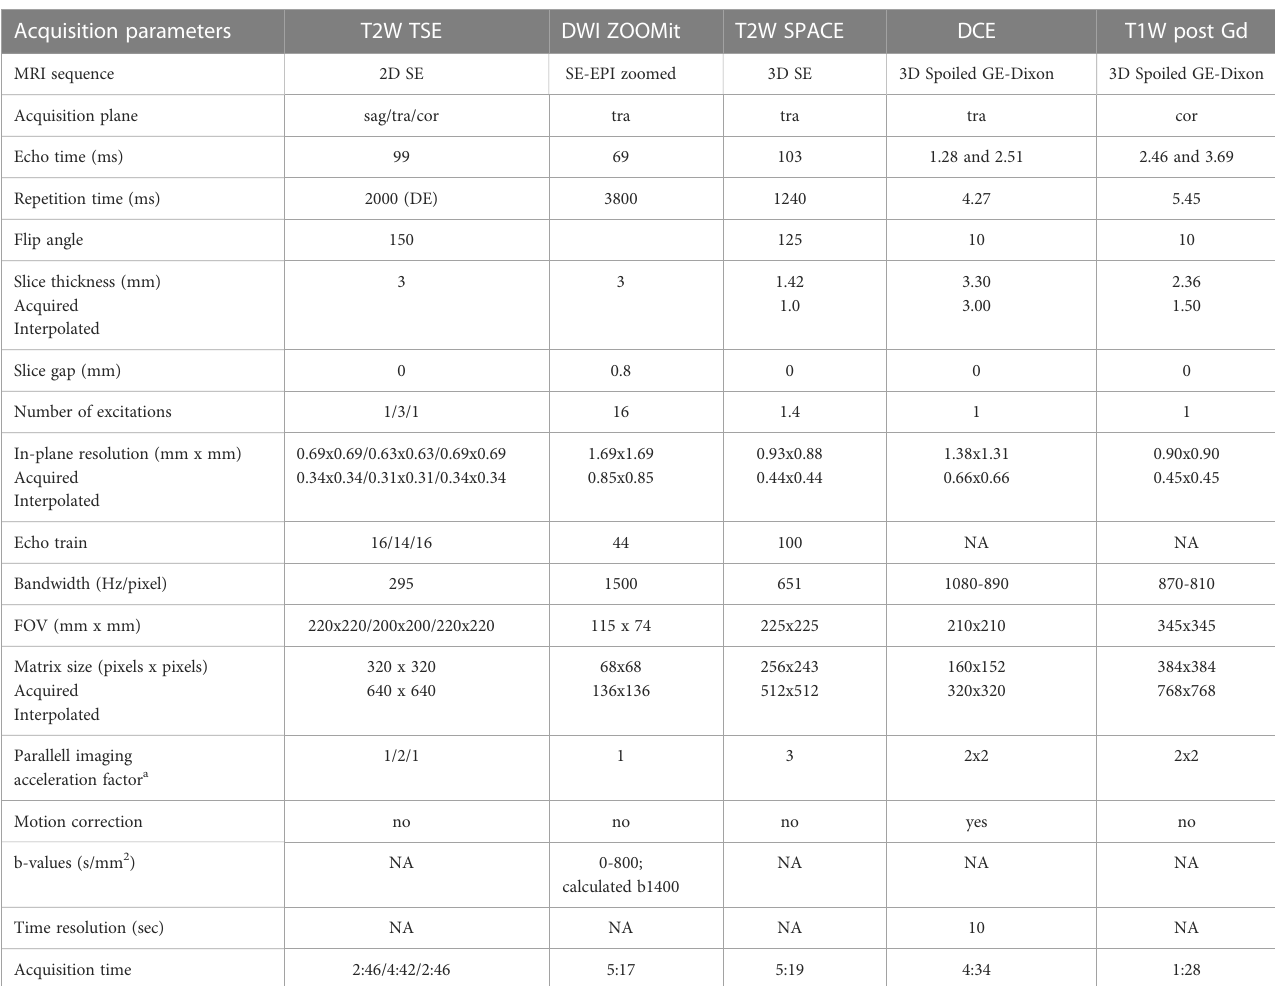
TABLE 2 The MRI scan